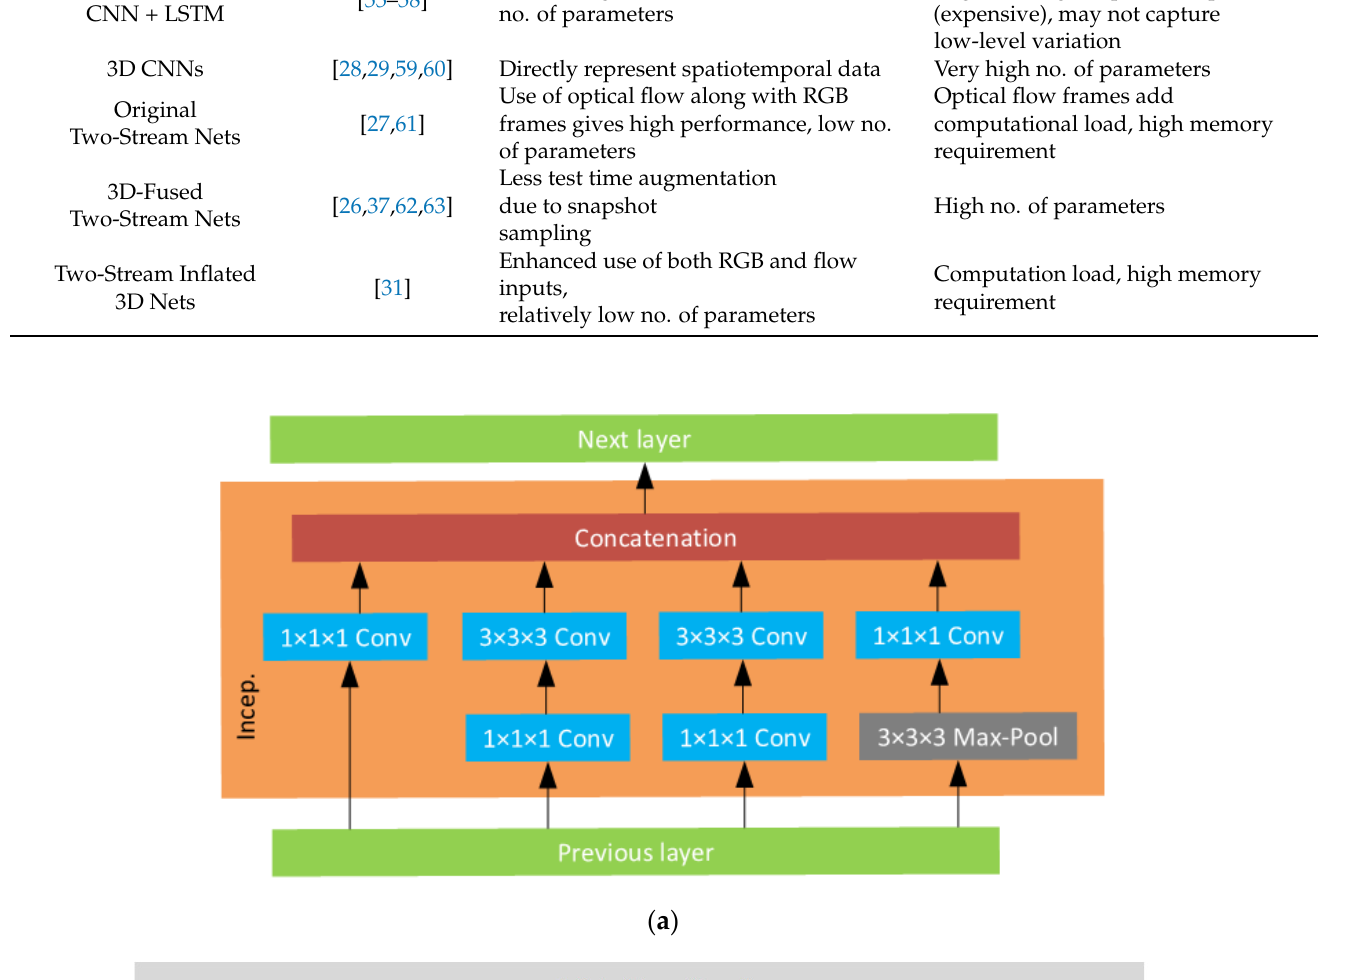
Figure 5. Implementation details of the model. Note that the architecture of each Conv3d layer shows the number of filters, size of the convolutional kernel, and stride. The architecture of each pooling layer includes the kernel size and stride. As evident from the dataset details discussed previously, the UFLV-DS is a small-sized dataset. Even though the study adopted several methods during experi-